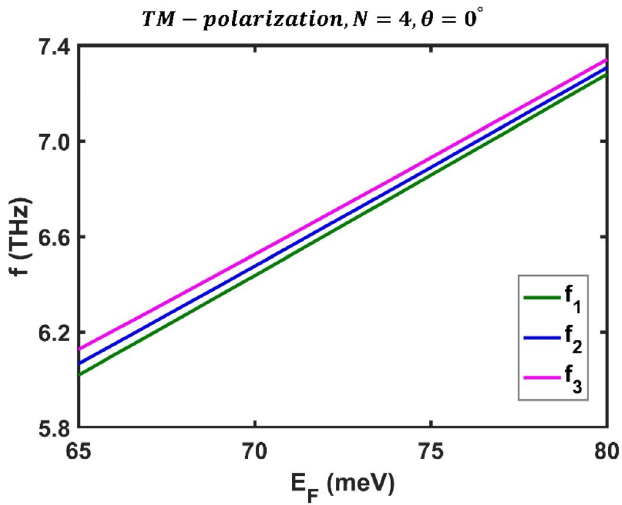
Figure 10. Variation of central frequency of all three optical channels with respect to Fermi energy for TM polarization state under normal incidence in the third-order F-1D PhC structure corresponding to period number N = 4 . The central frequencies of all three optical channels are shown in green, blue and magenta and changes from ( f 1 , f 2 , f 3 ) = ( 5.606, 5.664, 5.738 ) THz at E F = 60 meV to ( f 1 , f 2 , f 3 ) = ( 7.279, 7.307, 7.341 ) THz at E F = 80 meV.